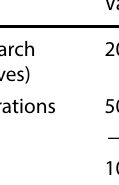
Table 5 Basic parameters and values of